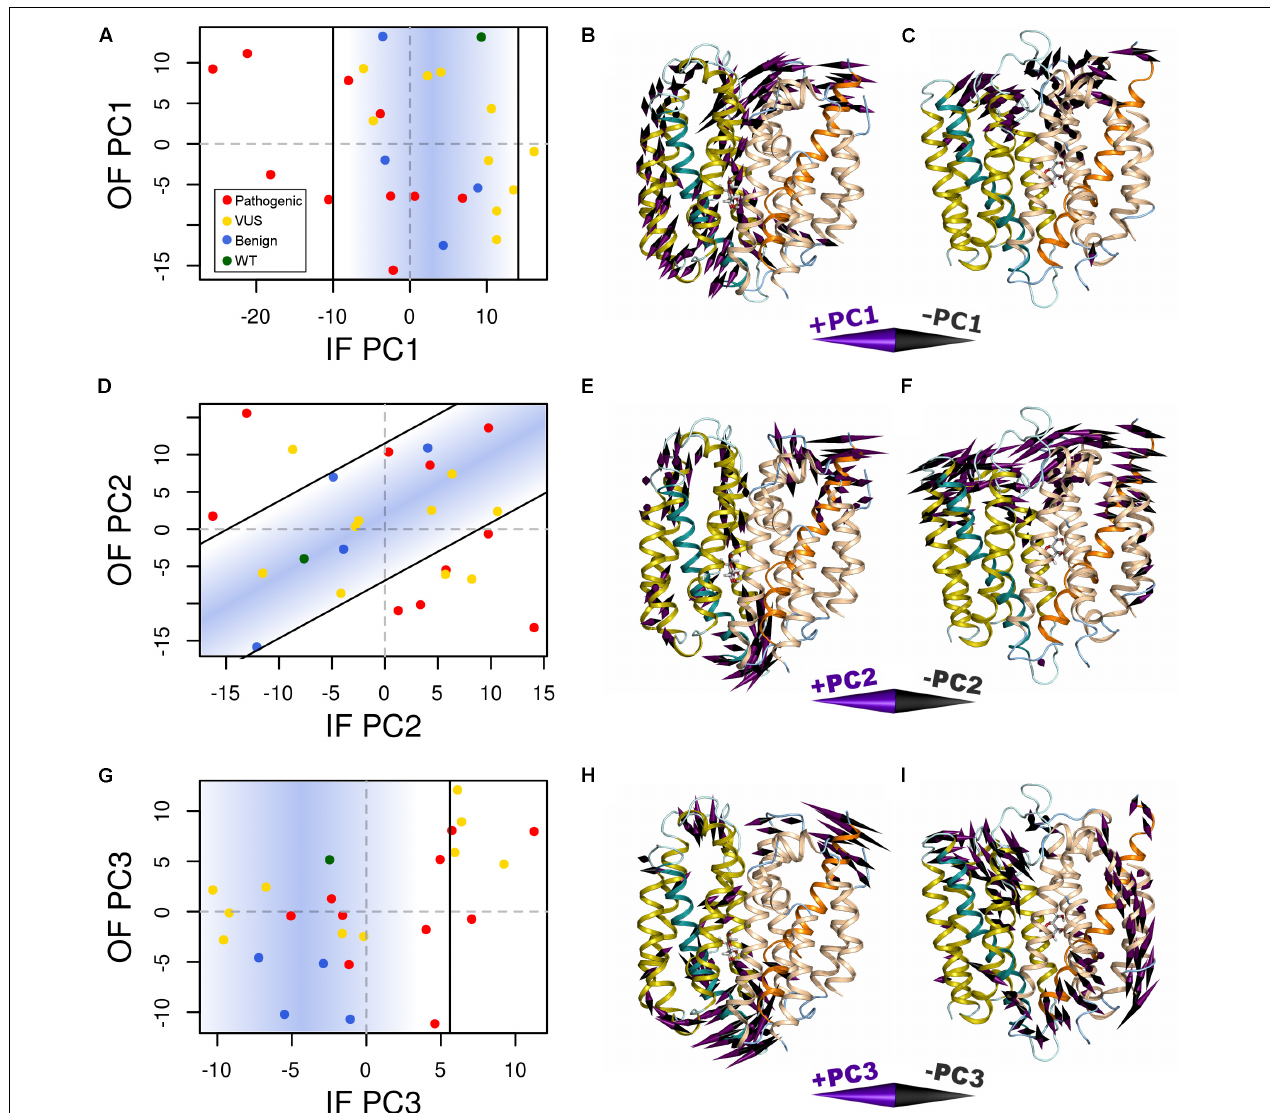
FIGURE 4 | Variants alter conformational dynamics. The conformational dynamics within our MD trajectories of GLUT10 were evaluated using PCA. (A) The median PC1 coordinate of each variant from each initial conformation is shown. Specific variants shifted the inward-facing (IF) dynamics in the negative direction further than was observed in any of the simulations of benign variants or the WT, while there is no clear separation between types of variants from the outward-facing (OF) dynamics. Black lines indicate the bounds of the densest 75% of WT and benign simulations, and a blue gradient is used to highlight this same region; see the section “Materials and Methods.” Variants whose median values are outside of this area are considered altered in the PC motion. (B) We visualized the IF PC1 in 3D by placing a cone at each residue that is proportional to its magnitude and direction. Small motions are omitted for clarity. The positive direction of IF PC1 indicates motion of the intracellular sides of H1, H3, and H4 away from the C-terminal bundle with shifting of H5 upward toward the extracellular side and motion of the extracellular sides of H8 and H10 away from the N-terminal bundle. These motions coincide with some of the transitions toward the OF conformation. (C) We visualized the OF PC1 in the same way. The dominant feature of this motion is movement of the extracellular sides of H5, H7, and H8. These motions coincide with some of the transitions toward the IF conformation. The motions apparent in (D–F) PC2 and (G–I) PC3 of each conformation are visualized in the same way. For each PC, we identified a line of discrimination that separated regions of PC space occupied by WT and benign variants from regions dominated by pathogenic